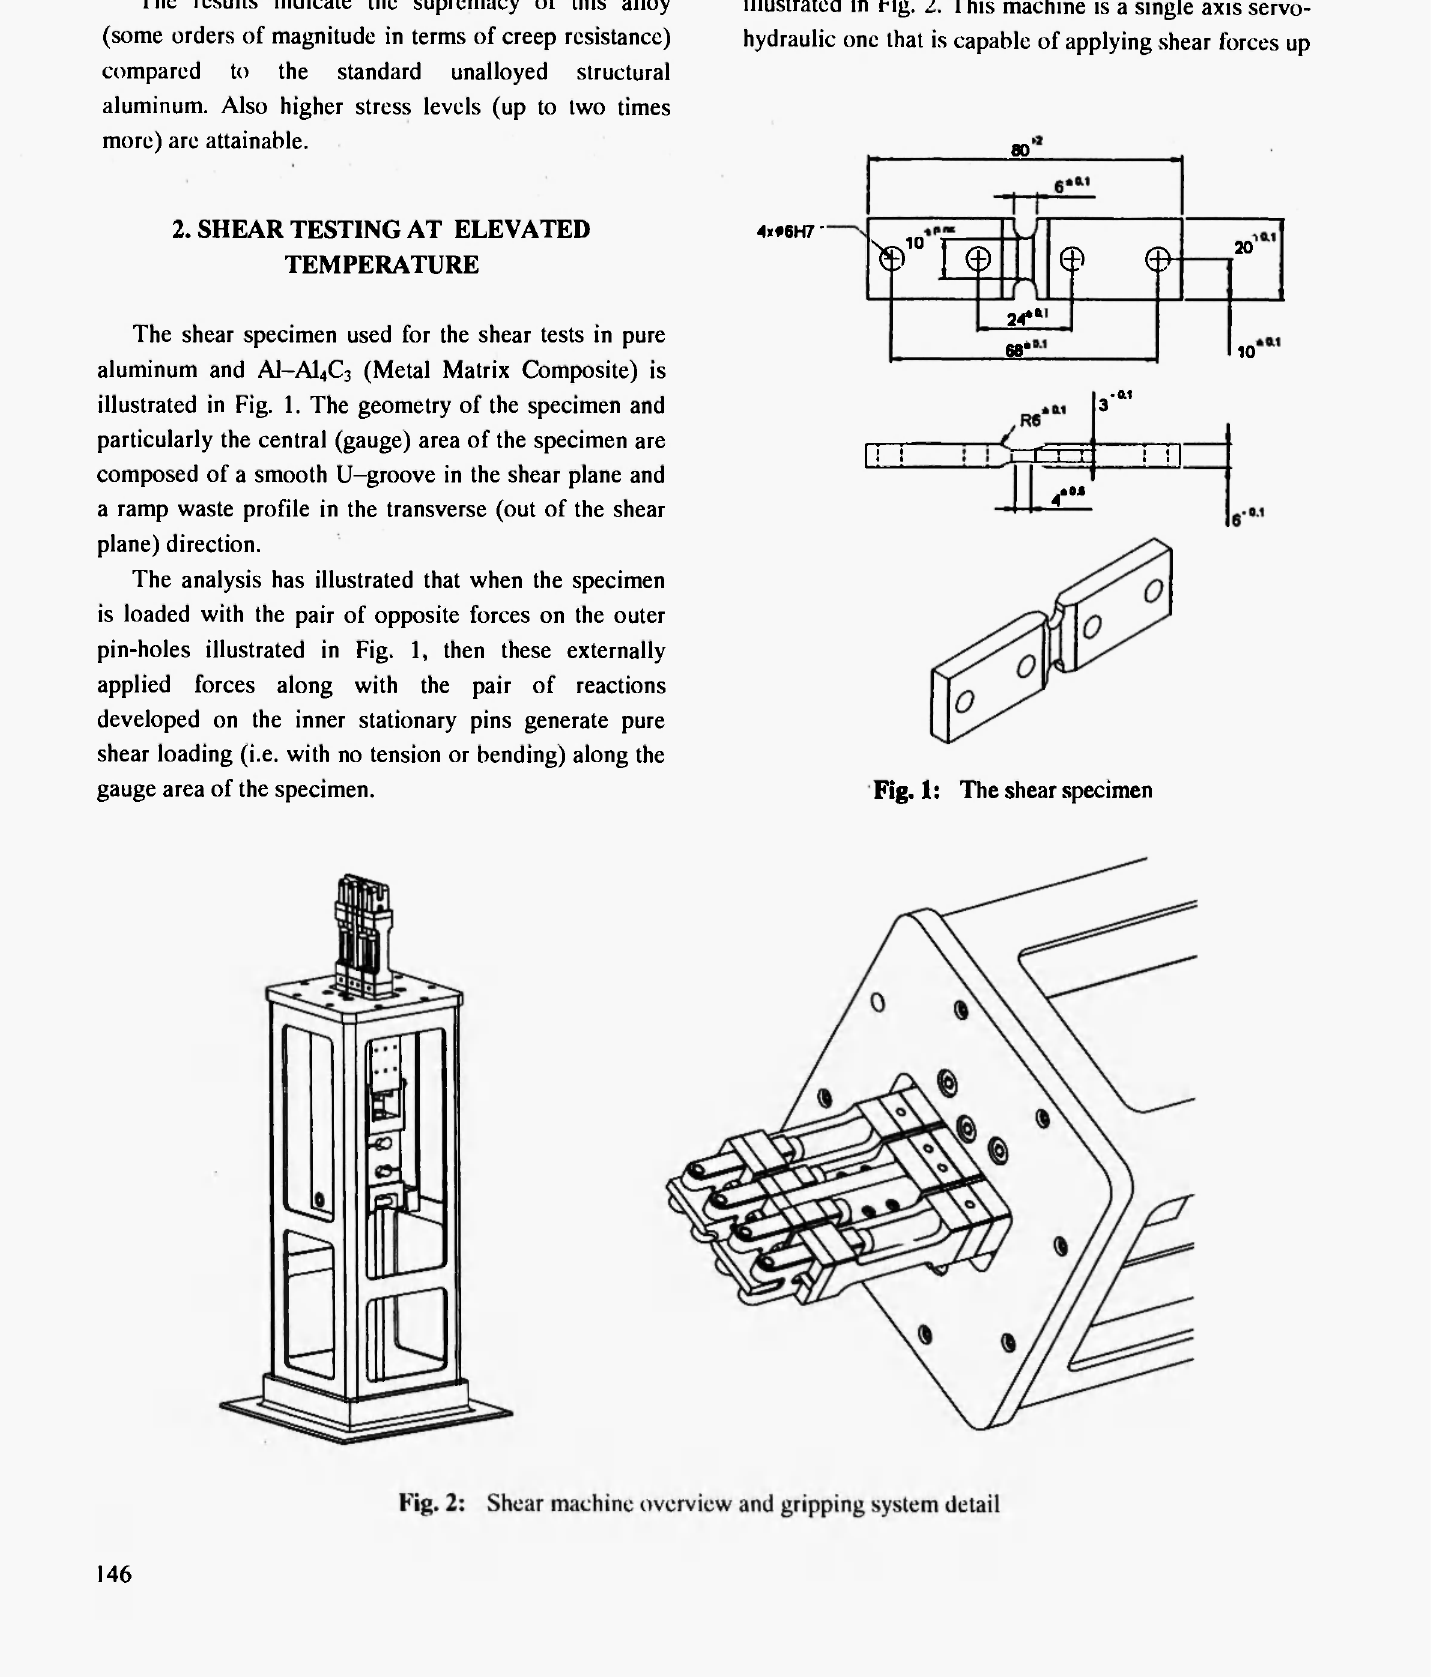
Fig. 1: The shear